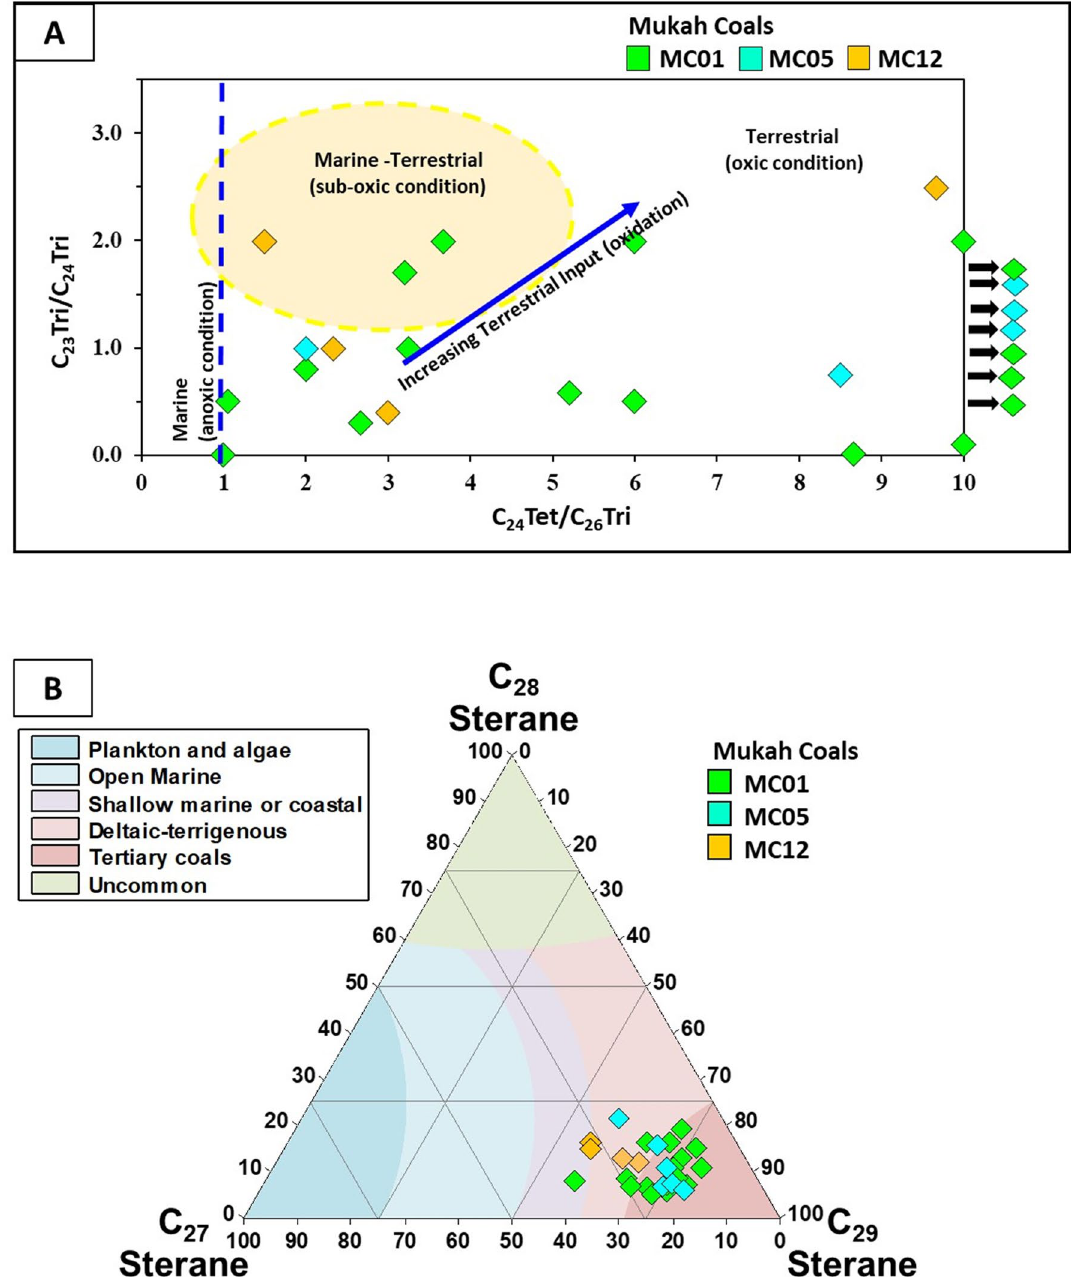
Figure 14. Plots of ( A ) C 23 Tricyclic/C 24 Tricyclic versus C 24 Tetracyclic/C 26 Tricyclic, and ( B ) C 27 , C 28 , and C 29 of regular steranes, showing the organic matter source input for the studied Mukah coals,